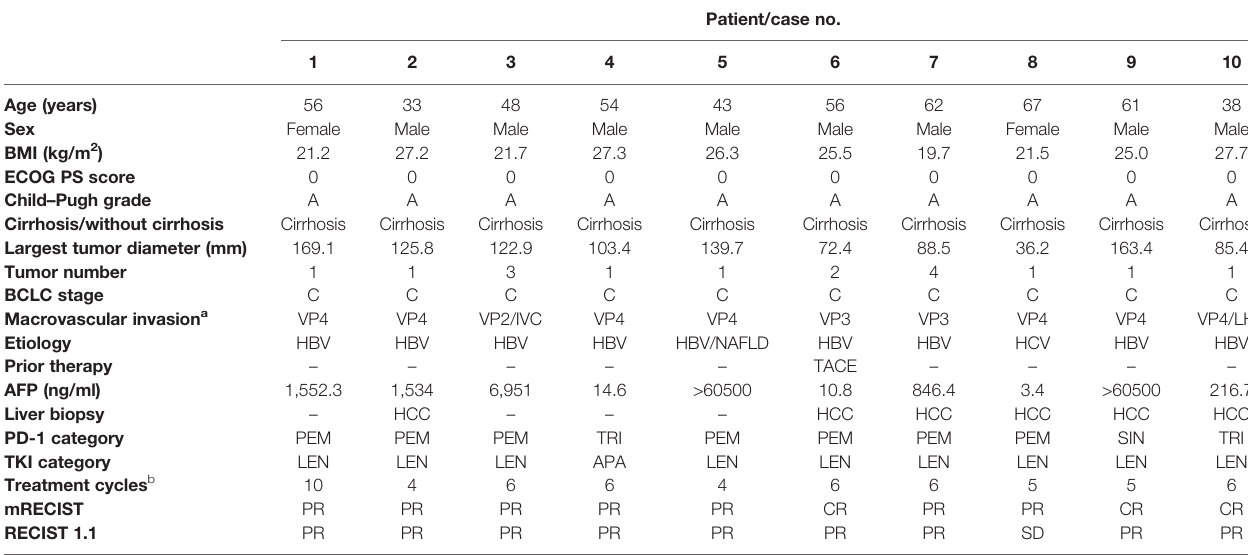
TABLE 1 | Clinical characteristics of patients.